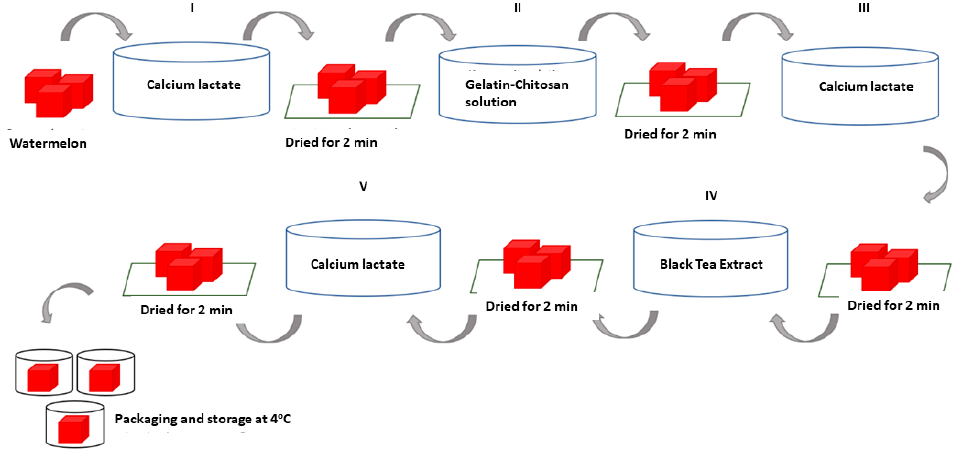
Figure 1. Layer-by-layer technique of edible